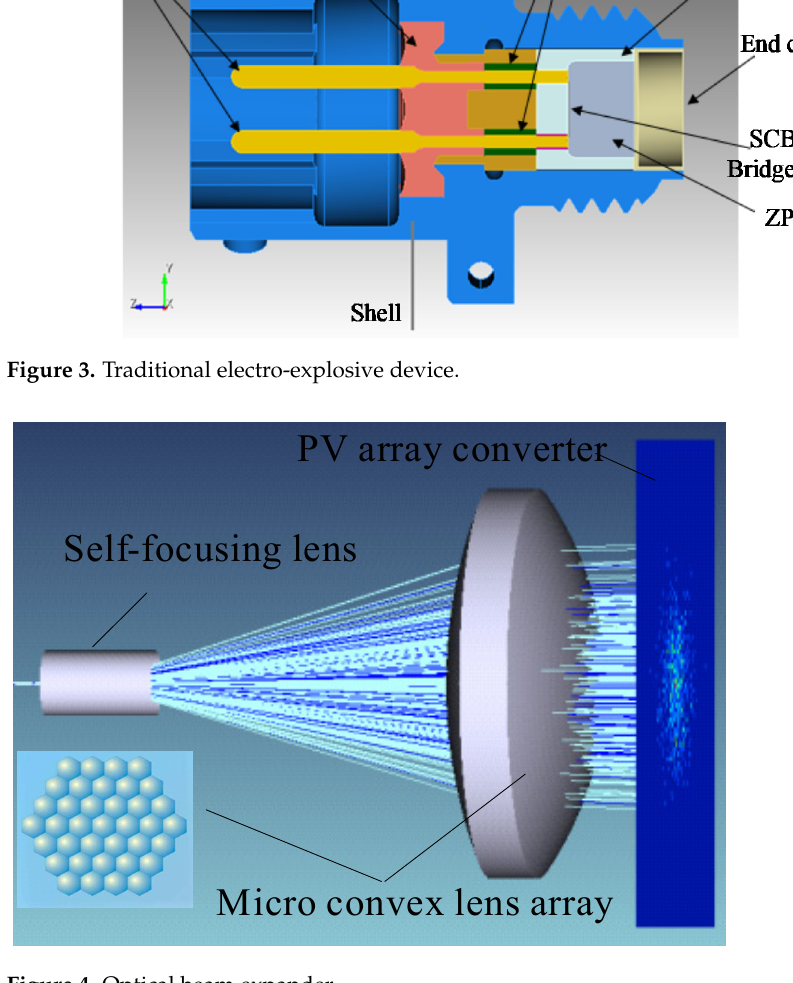
Figure 4. Optical beam expander.